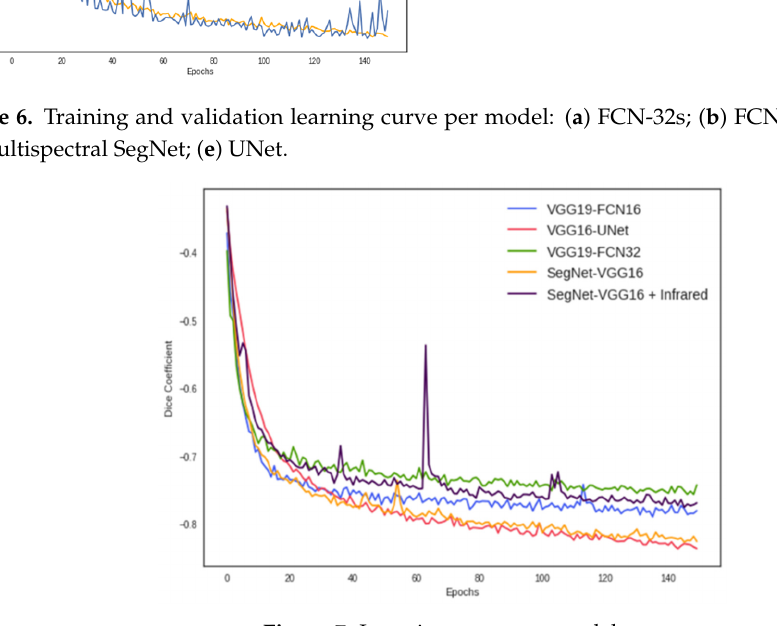
Figure 7. Learning curve per model.